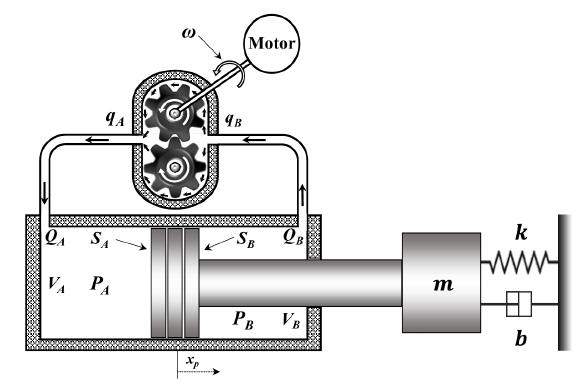
Figure 1. Structure of the single-rod electro-hydrostatic